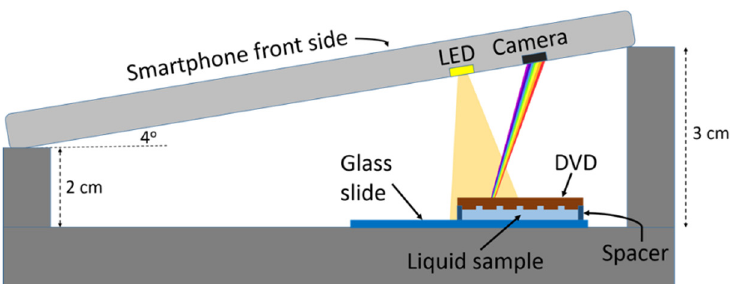
Figure 3. Schematic illustration of the smartphone optosensing platform for measuring the refractive index of liquid samples. Smartphone built-in LED flashlight and camera are used for illuminating a DVD grating and detecting reflected diffraction patterns, respectively. The liquid sample wets the grating surface in a fluidic cell. The diffraction intensity depends on the liquid sample refractive index.